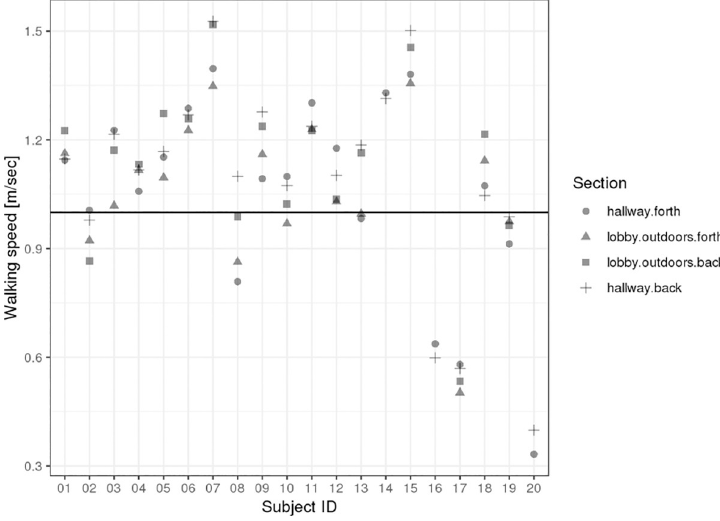
Fig 1. Range of speed. Variability of the mean reference speed per parcours section as measured with the measurement wheel for each subject.